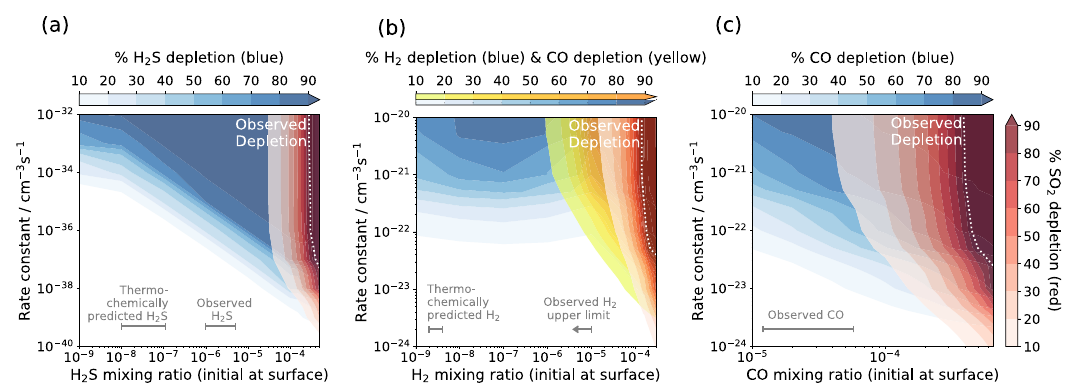
Fig. 1 Depletion contours of metabolic inputs. Contour plot showing depletion of metabolic reagents within the cloud layer for each metabolic pathway, ( a ), ( b ), and ( c ). Depletion is shown as a function of net metabolic rate (y-axis) and initial surface mixing ratio of the limiting metabolic reagent species (x- axis). The depletion of each species is calculated with respect to the species' column abundance in a reference model run without the metabolism present. The predicted or observed surface mixing ratios of metabolic reagent species and their 1 σ errors are indicated with grey errorbars 6 , and the metabolic models reproducing SO 2 -depletion are indicated with a white